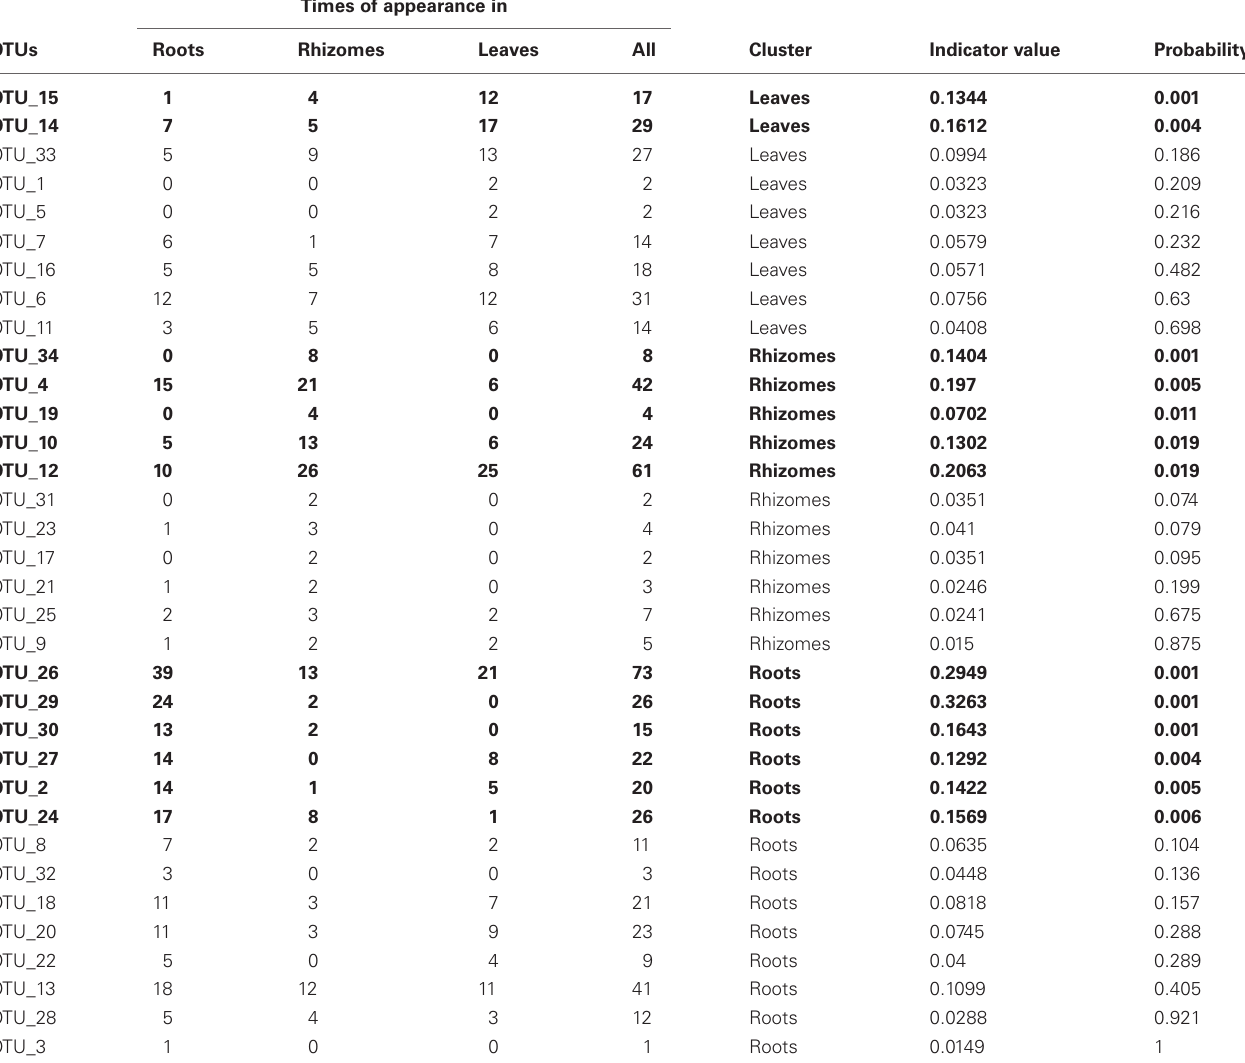
Table 2 | Indicator species